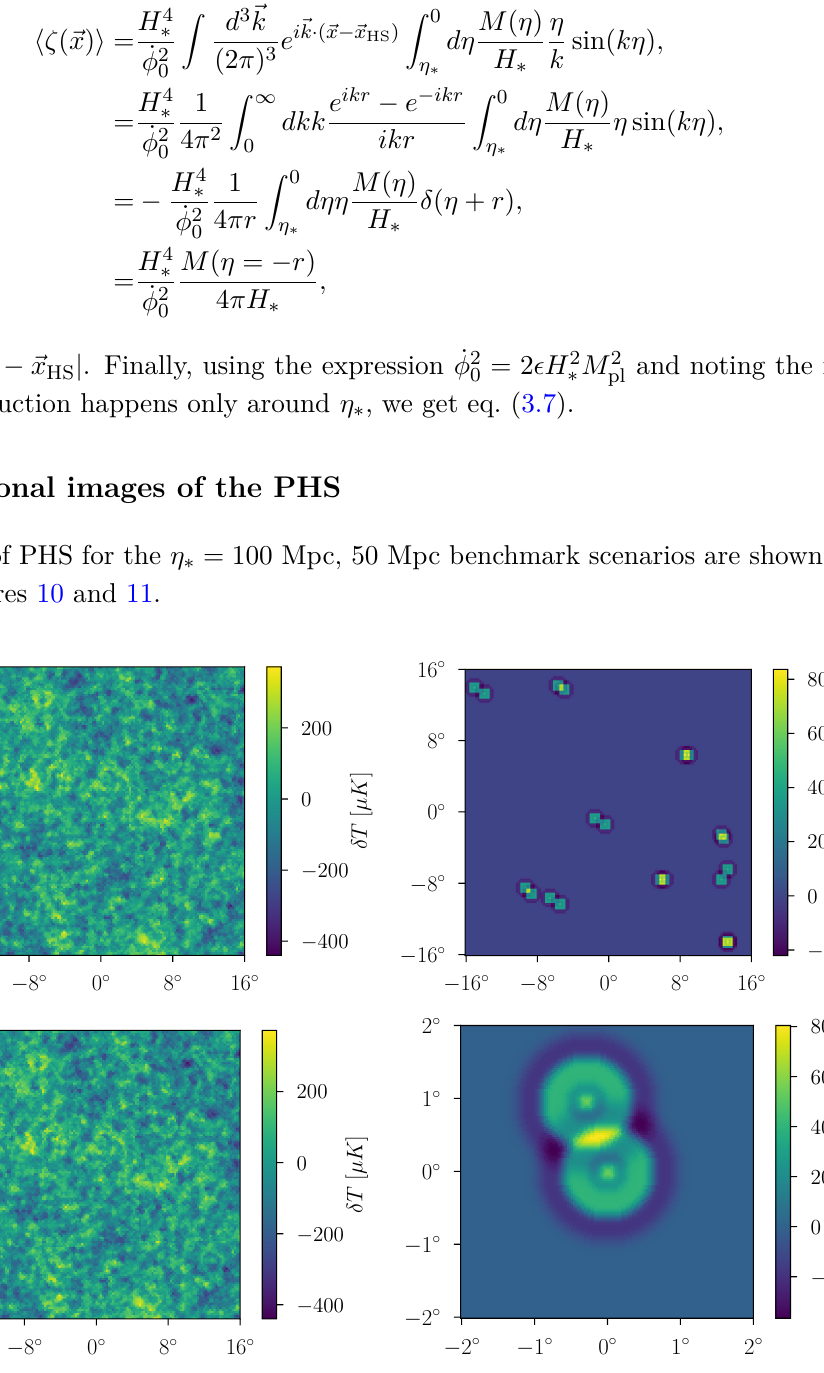
Figure 10 . Local patches of (upper-left) CMB + PHS, (upper-right) PHS, and (lower-left) CMB, generated within a region of longitude = [ − 16 ° , 16 ° ] and latitude = [ − 16 ° , 16 ° ] centered at ( θ, φ ) = ( π/ 2 , 0) and projected onto the Cartesian coordinates ( 140 × 140 pixels) using N = 256 . The side shape of PHS is based on the η = 100 Mpc mode using g = 6 , and the separation distance is ∗ r sep = 0 ∼ 6 pixels. In total, ten PHS signals are injected using a flat distribution. (lower-right) A higher-resolution image of the PHS using N = 2048 side